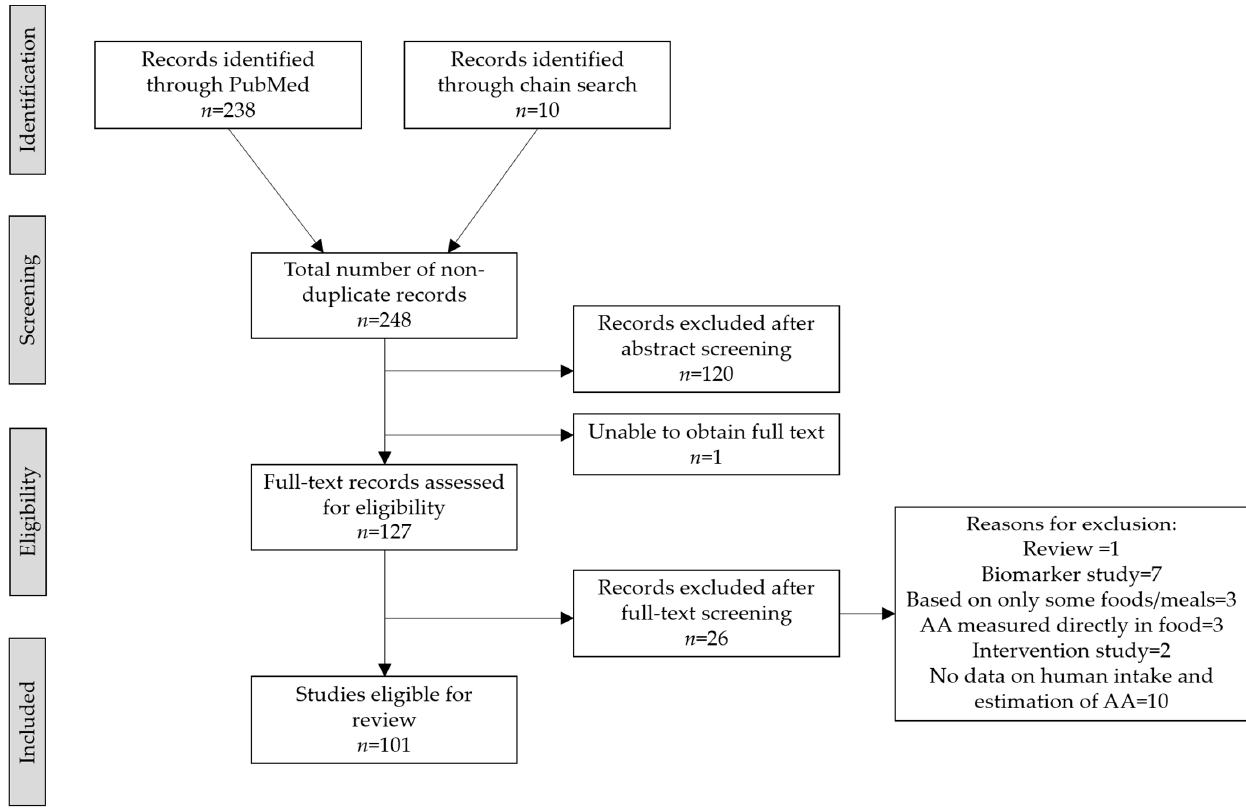
Figure 2. Prisma